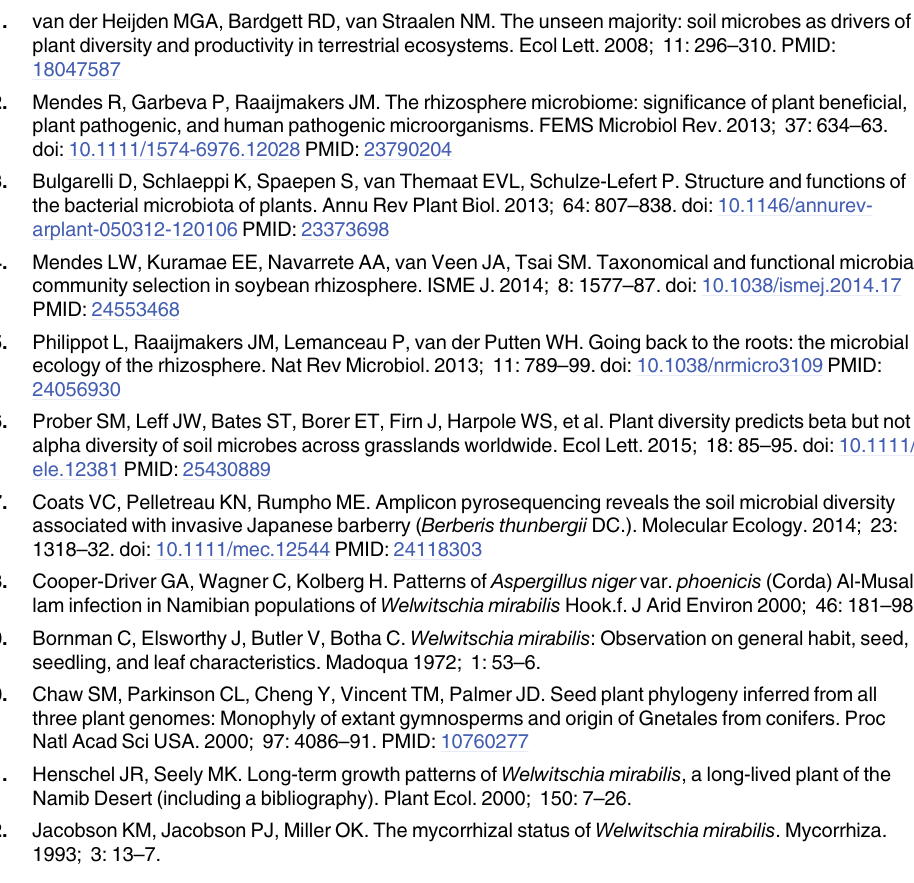
S4 Fig. Venn diagram showing the number of shared phylotypes observed between the rhi- zosphere samples. a) bacteria, b) fungi. Sample nomenclature is as in S1 Table. S1 Table. Bacterial diversity. Sample nomenclature indicates the sample type (S = bulk soil;